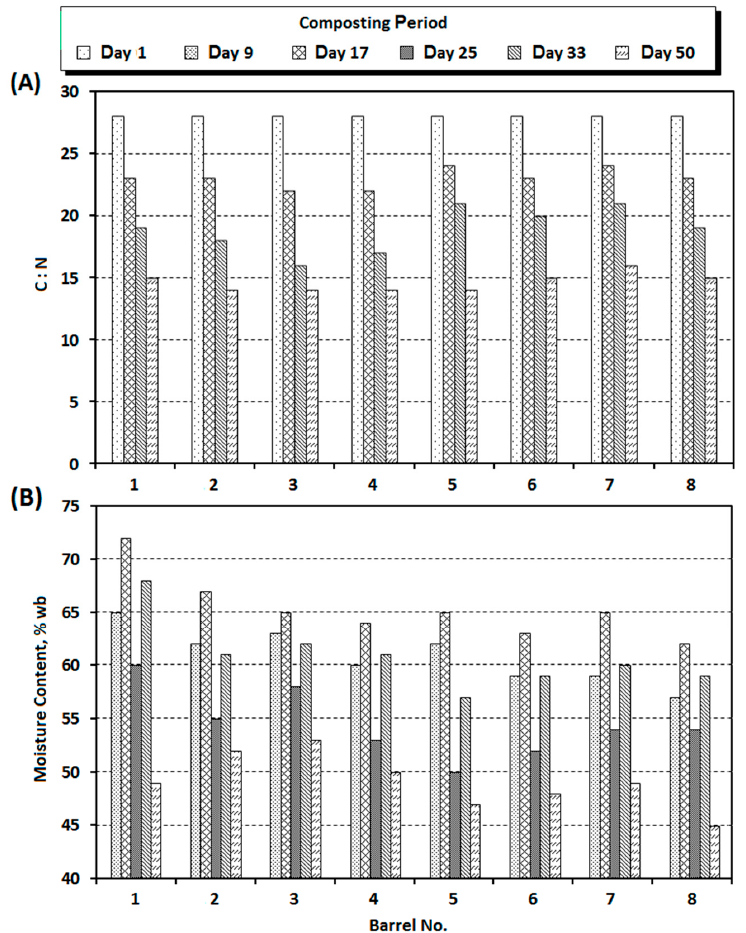
Figure 6. ( A ) Carbon to Nitrogen ratio (C/N) and ( B ) moisture content of composting mass on dif- ferent days of composting